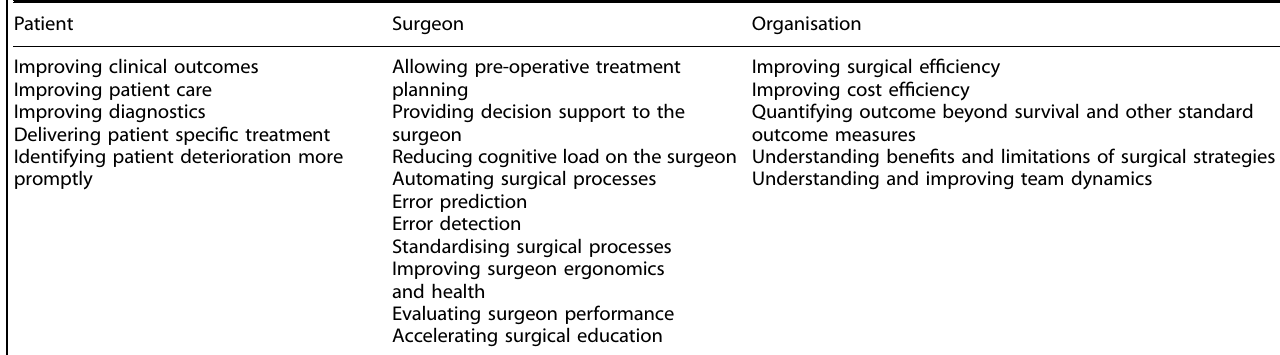
Table 1. Bene fi ts of digital surgery identi fi ed by the Delphi panel. Patient